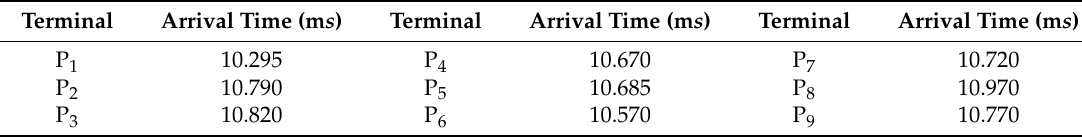
Figure 10. Identified three-terminal fault section for fault F1.